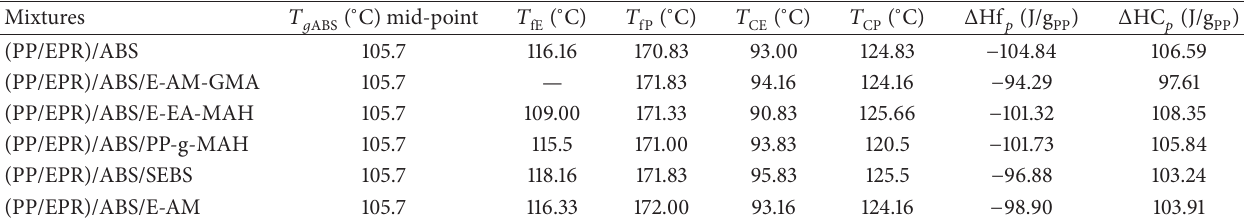
Table 8: Thermal characteristics of the blends (PP/EPR)/ABS/compatibilizer at rate of 5% of each one of the five compatibilizers. Mixtures